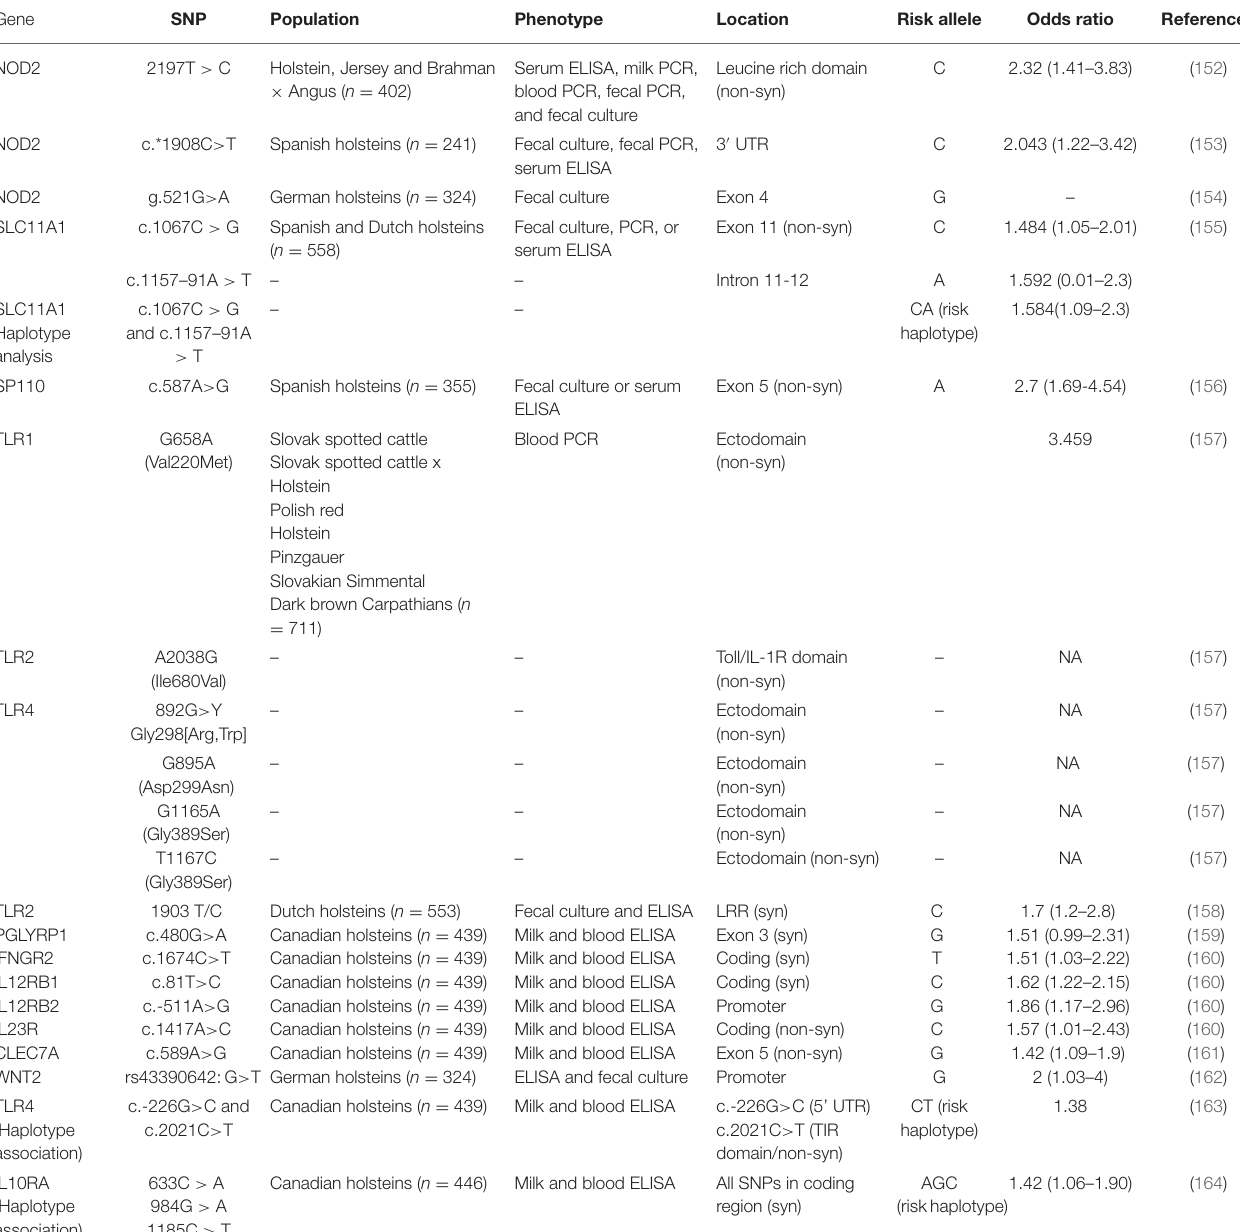
TABLE 2 | List of Johne’s disease candidate gene studies in cattle.